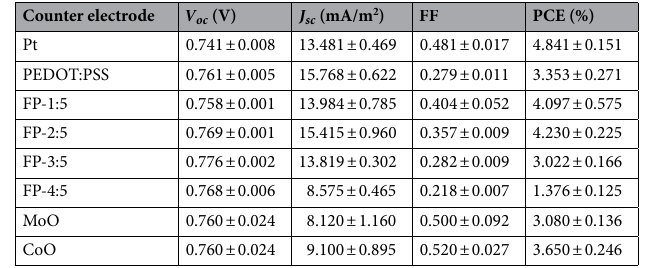
Table 3. A comparison of photovoltaic parameters of DSSCs assembled with various CEs, obtained at a 100 mW/cm 2 (AM 1.5G) light intensity.